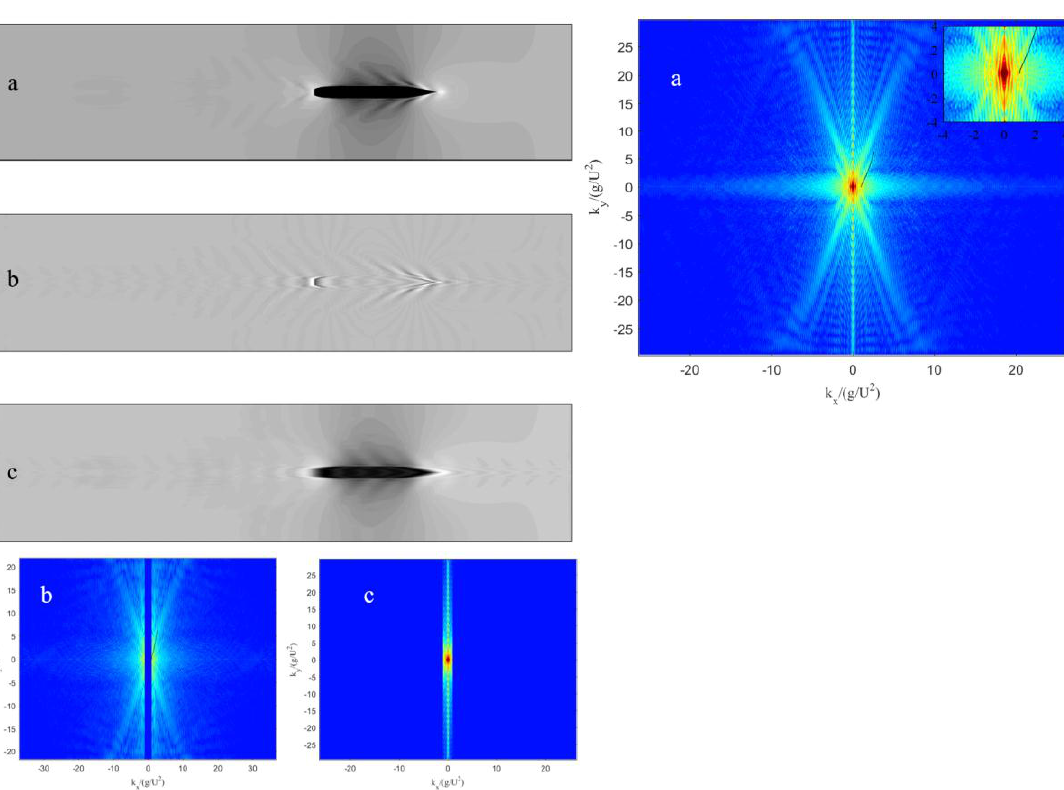
Figure 15. Free surface disturbance in the rectangular canal, 𝐹 ℎ = 0.57; ( a ) Computed free surface. ( b ) Far-field and ( c ) near-field representations in the real and spectral space ( 𝑘 𝑥𝑐 = 9.5796). Longitudinal extent: 16.5 m.